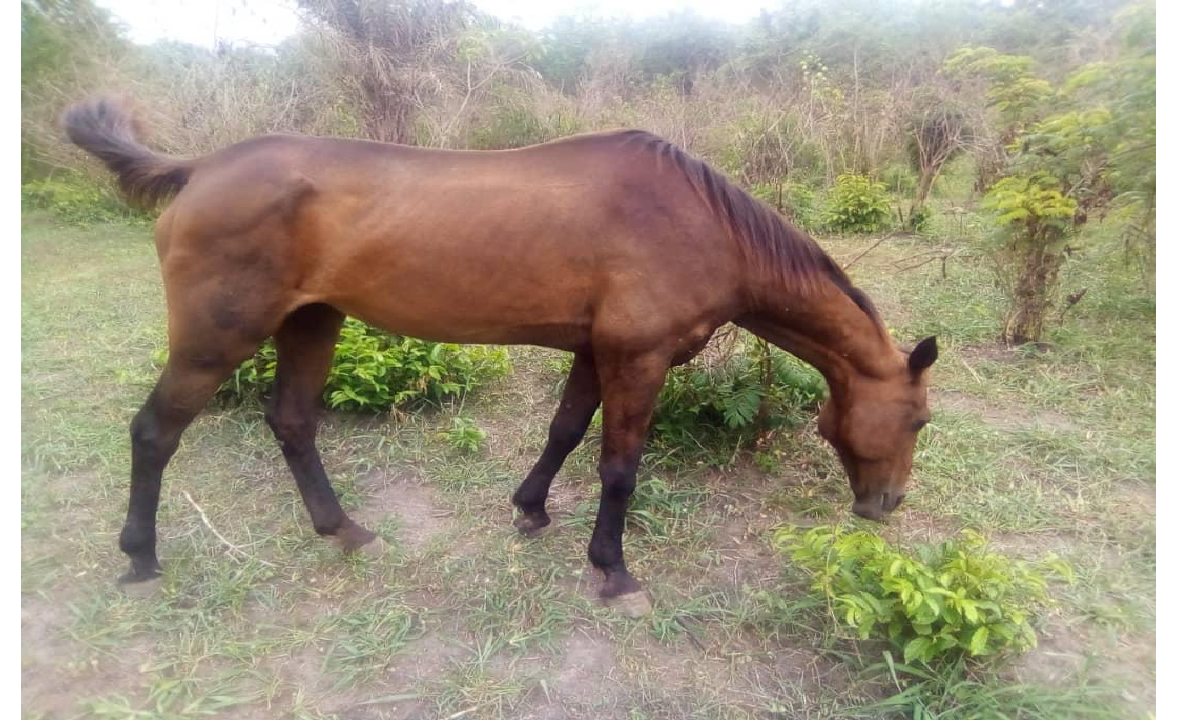
Fig. 2: stallion after full